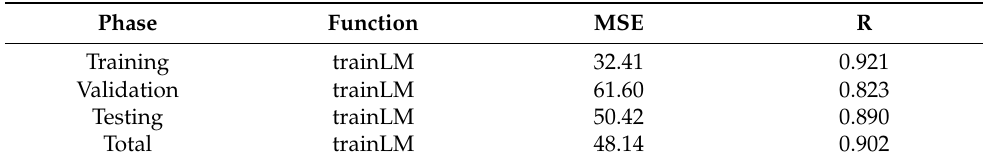
Table 4. Summary of LM algorithm model assessment